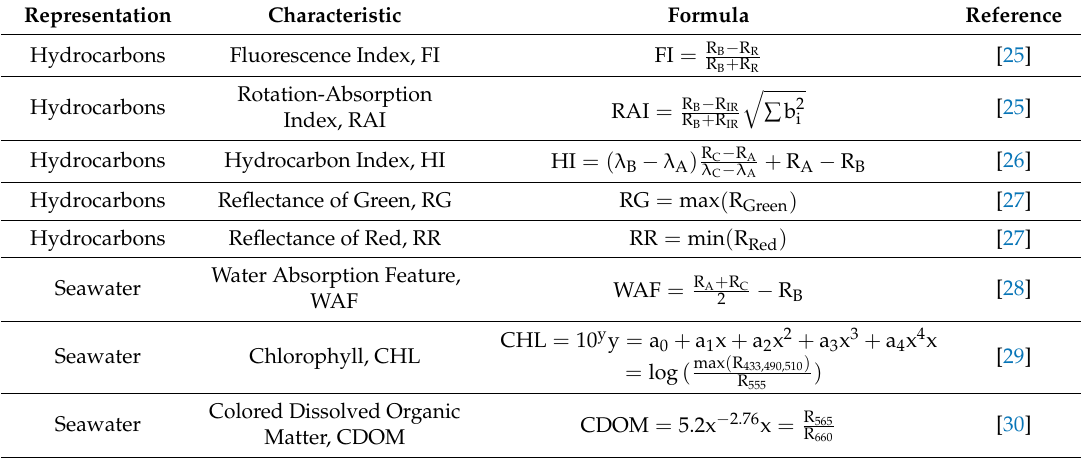
Table 2. The spectral indices involved in this